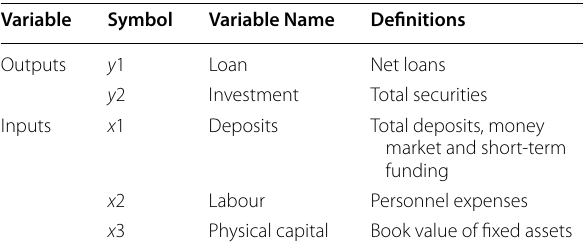
Table 3 Variables of outputs and inputs. Source : Hassan et al. [30] and Johnes et al. [35] Variable